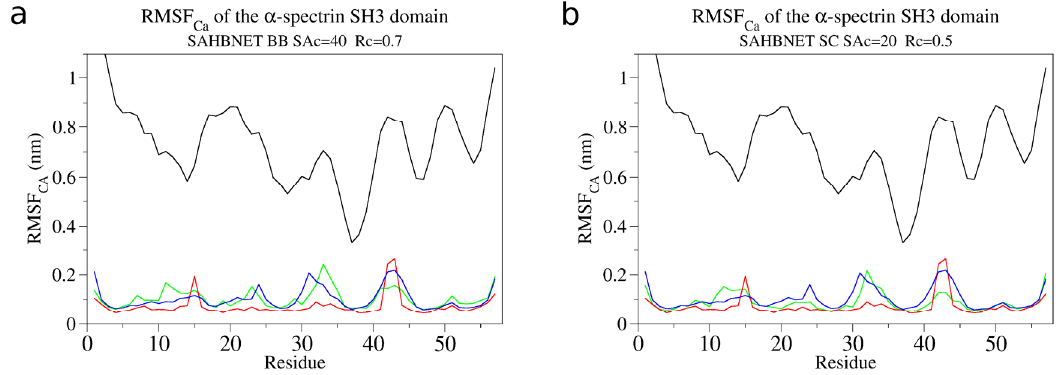
= 40%, R = 0.7 nm and c c = 20%, R = 0.5 nm and K 1000 kJ/nm 2 ] CG c c SPRING domain. 3